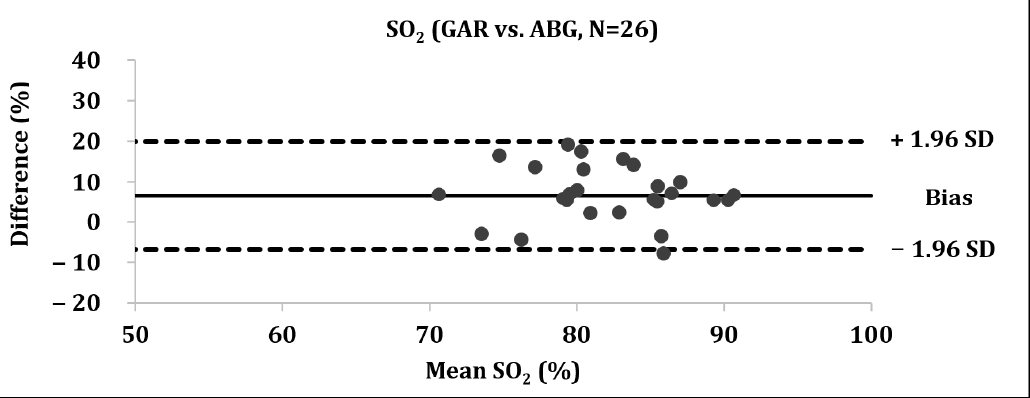
( a ) SO 2 GAR vs. ABG. Figure 3. Cont